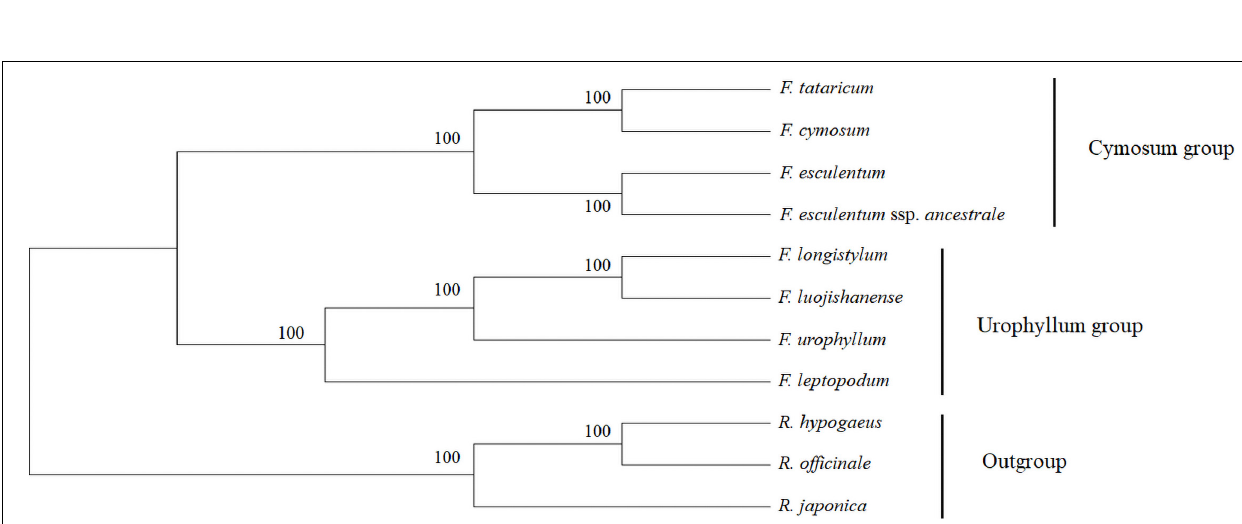
Frontiers in Plant Science |